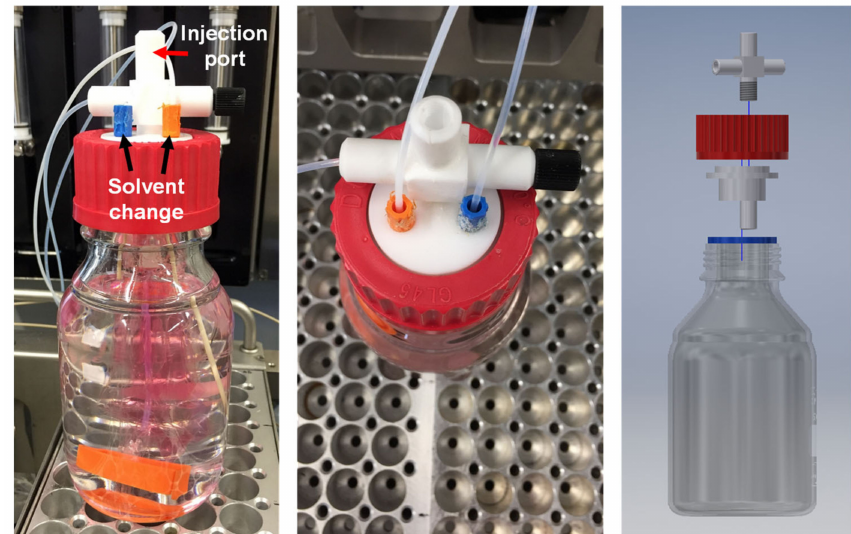
Figure 1. Automated dialysis apparatus installed within the synthesis robot. The 250 mL glass vessel was equipped with a special Teflon cap consisting of an injection port for the four-needle head of the robot as well as possibilities for the solvent exchange (solvent pumping). The dialysis tube is located within the vessel filled with a solution of P2 .